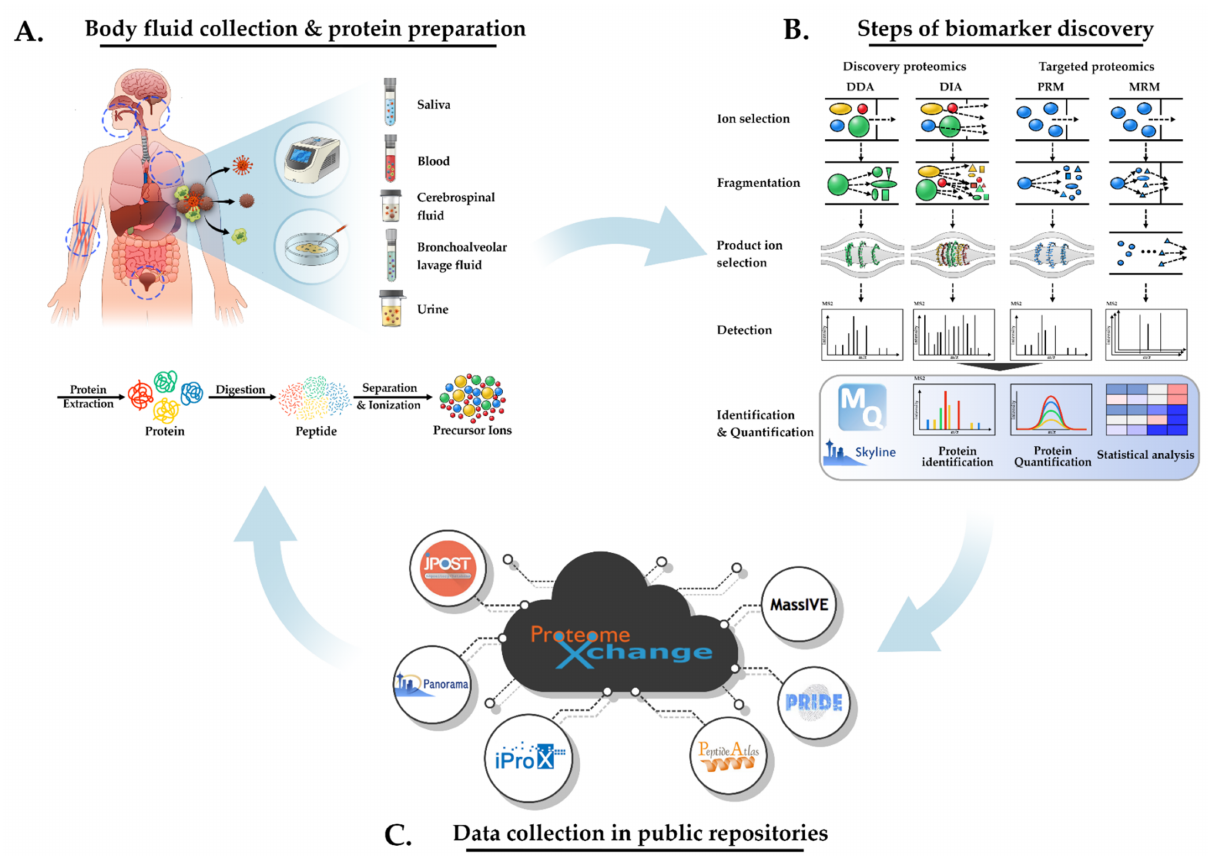
Figure 1. Schematic depictions of liquid chromatography-mass spectrometry (LC-MS) to